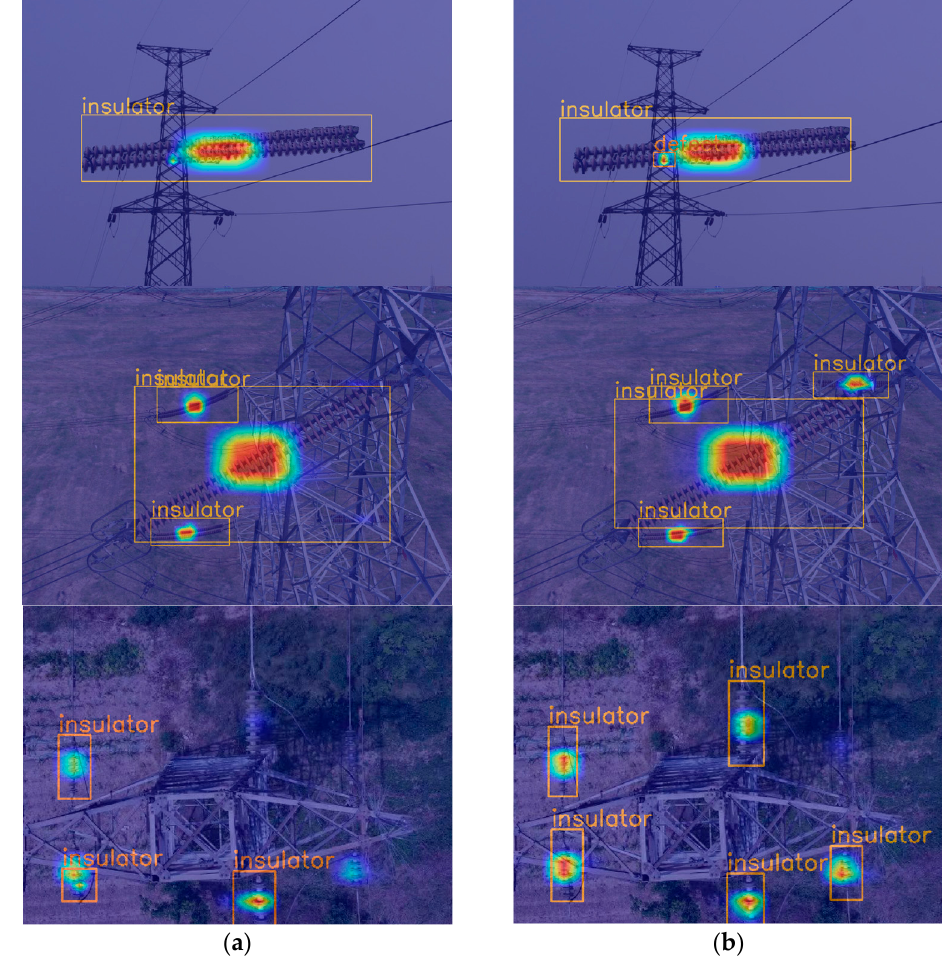
Figure 12. Heat map visualization: ( a ) YOLOv4–GhostNet algorithm; ( b ) YOLOv4–GhostNet–ECA algorithm.